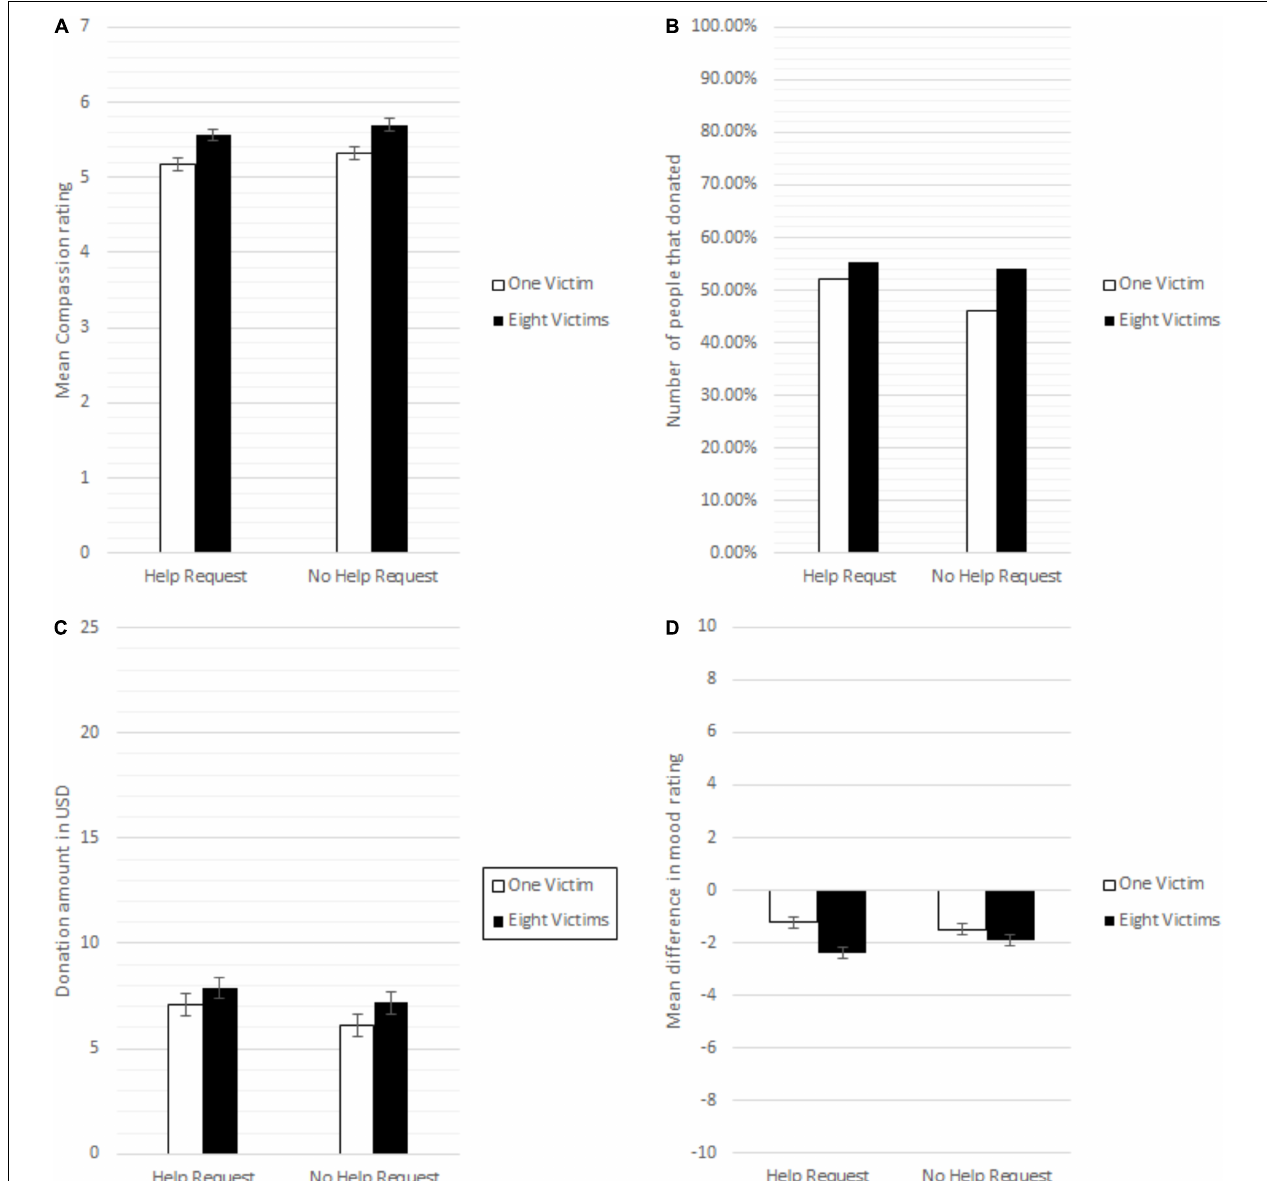
FIGURE 1 | (A) Mean compassion toward the child (children) across conditions (higher number indicates more compassion). (B) Number of participants that choose to donate across conditions. (C) Mean donation amount in USD split by help request and number of victims’ condition. (D) Mean change in mood ratings between baseline and after viewing the child/children (lower number indicates a more negative mood). Error bars are